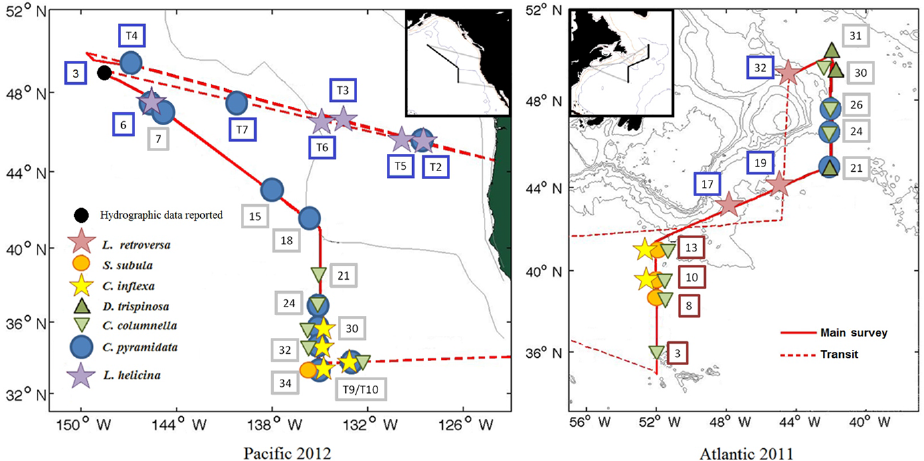
Figure 1. Cruise tracks and animal sampling. Thecosomes were collected at night at stations along the main survey transect (solid line) and at stations during transit (dashed line) during cruises to the northwestern Atlantic in 2011 and northeastern Pacific in 2012. The shapes correspond to the species caught at each station and used in this study. Blue (10 ◦ C), grey (15 ◦ C), and red (20 ◦ C) boxes around the station numbers (#) correspond to the temperature that was representative of 25–100m at each station (Table 2) and used in the experiments with animals from that